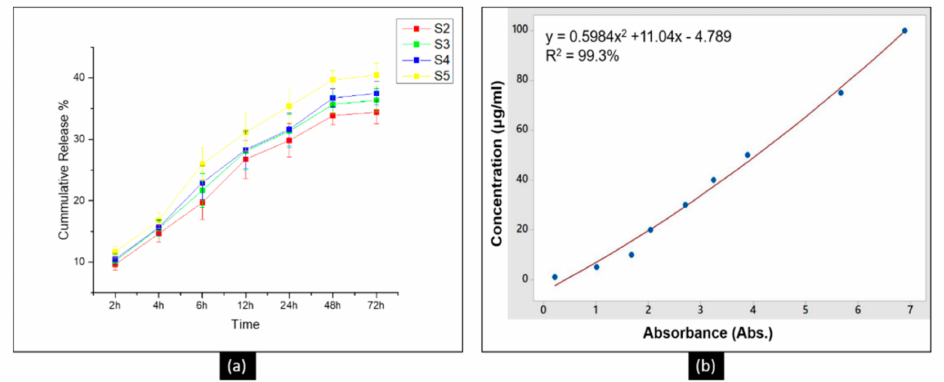
Figure 7. ( a ) In vitro release profile of DLF from PAN nanofibers (S2, S3, S4, and S5) in PBS, ( b ) cali- bration curve of the DLF in PBS showing regression model and coefficient of determination (R 2